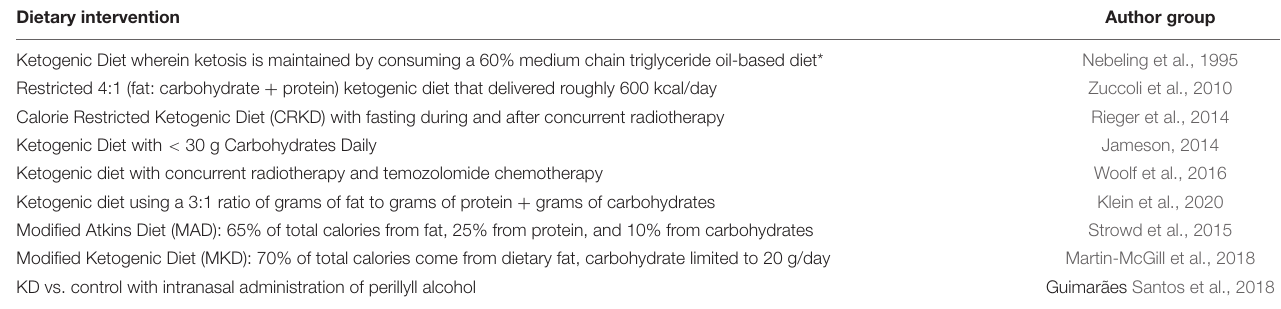
TABLE 1 | Clinical trials featuring dietary interventions to treat Glioblastoma multiforme. Dietary